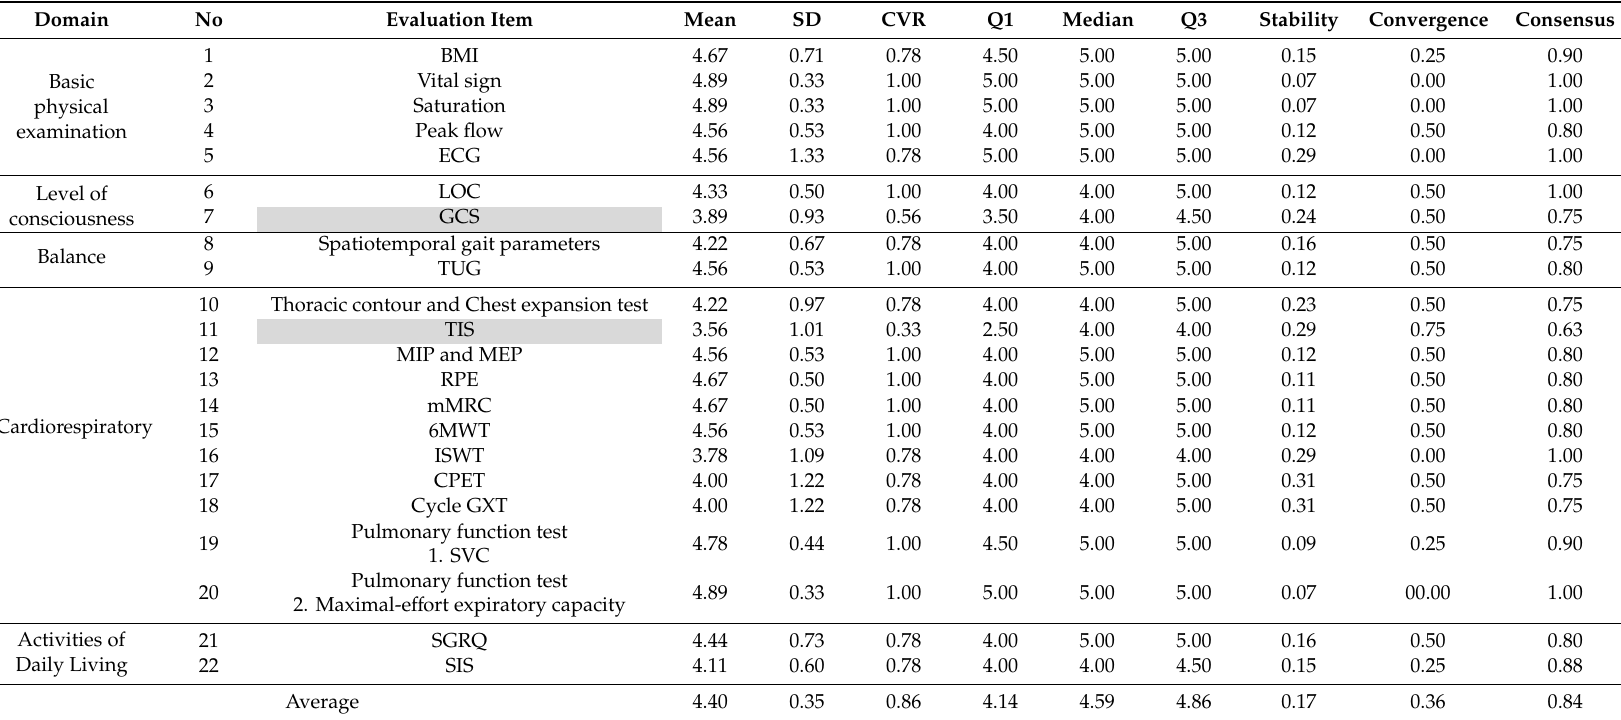
Table 11. Results of items after the second modified Delphi